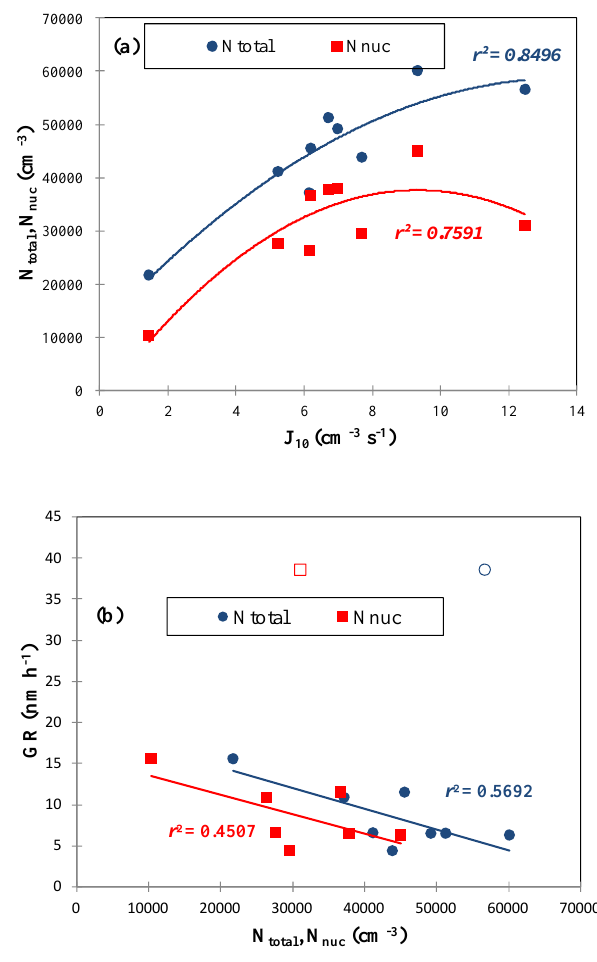
Fig. 10. (a) Responses of the total and nucleation mode particle number concentrations ( N total and N nuc ) to the changes in the nu- cleation mode particle formation rate ( J 10 ); (b) dependence of par- ticle growth rate (GR) to the particle number concentrations ( N total and N nuc ) during the NPF episodes analyzed in this study. The de- pendencies are illustrated with quadratic (PNCs vs. J 10 ) or linear (GR vs. PNCs) curve-fitting. The open symbols in (b) denote the outlier case of extremely high GR (see main text for